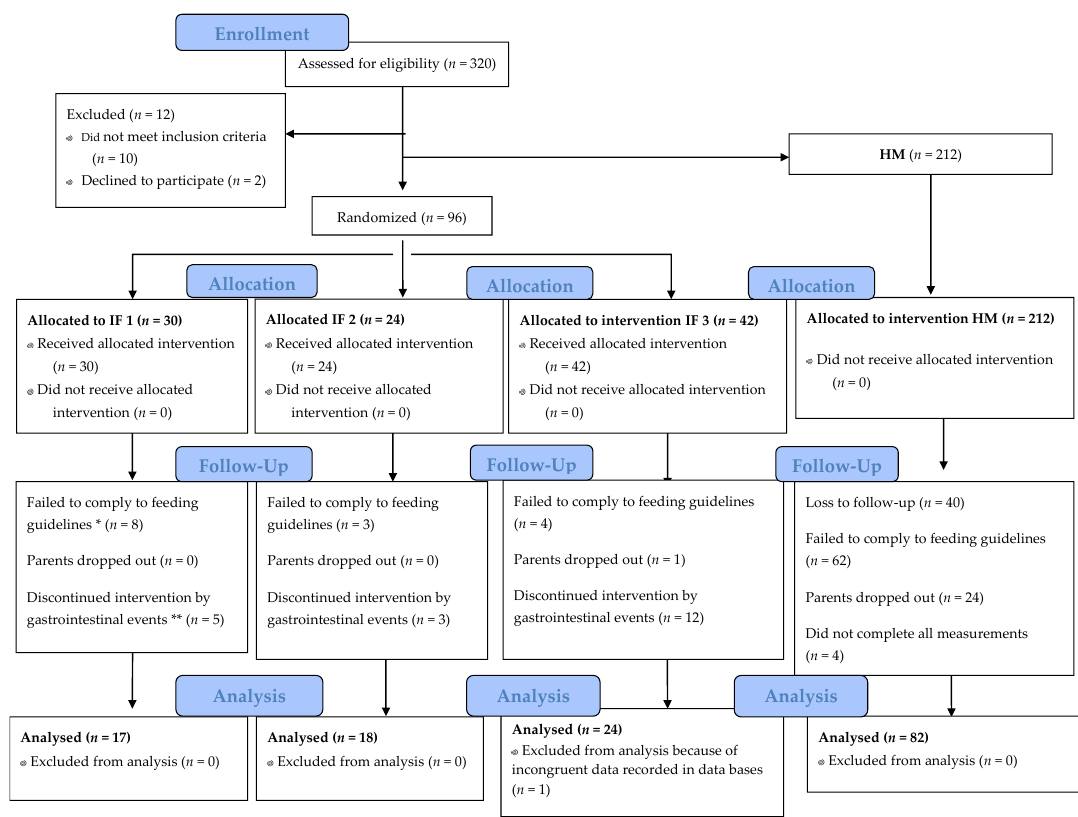
Figure 1. Study flowchart. * Failed to comply to feeding guidelines refers to infants who received mixed feeding (breastfeeding and infant formula) and/or complementary food before four months of age. ** Mothers reported gastrointestinal events such as vomiting, constipation, diarrhea, abdominal inflammation, and crying.